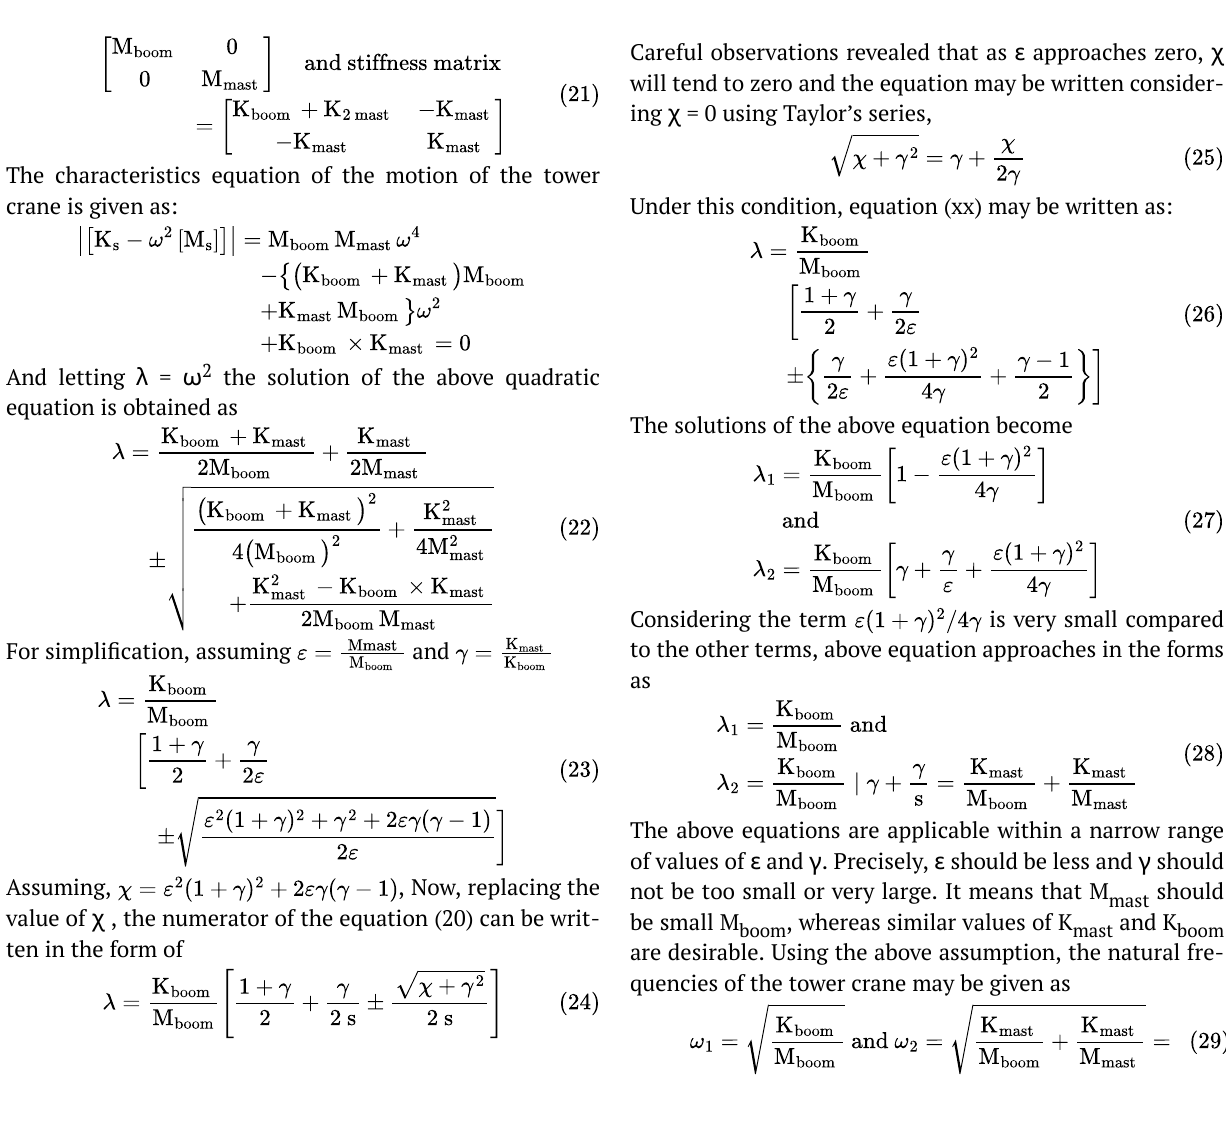
Figure 4. Tower crane and its equivalent spring model in series